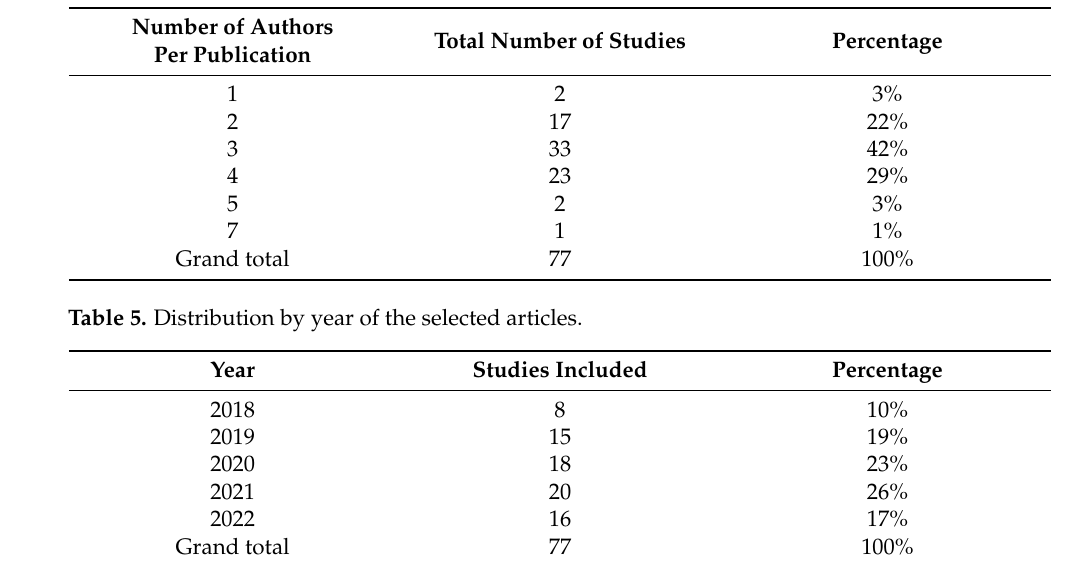
Table 4. Number of authors per publication.